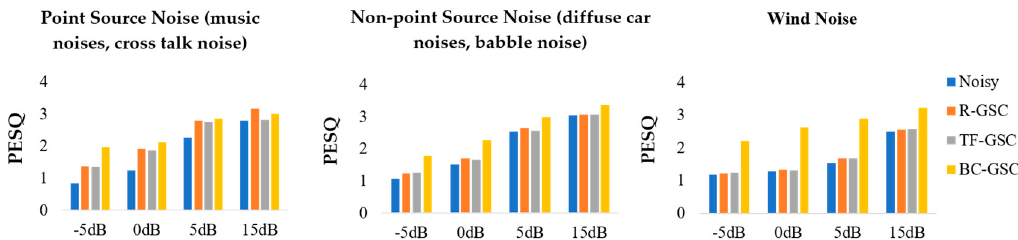
Figure 11. The perceptual evaluation of speech quality (PESQ) of the R-GSC, the TF–GSC and the proposed BC–GSC methods in different noises.